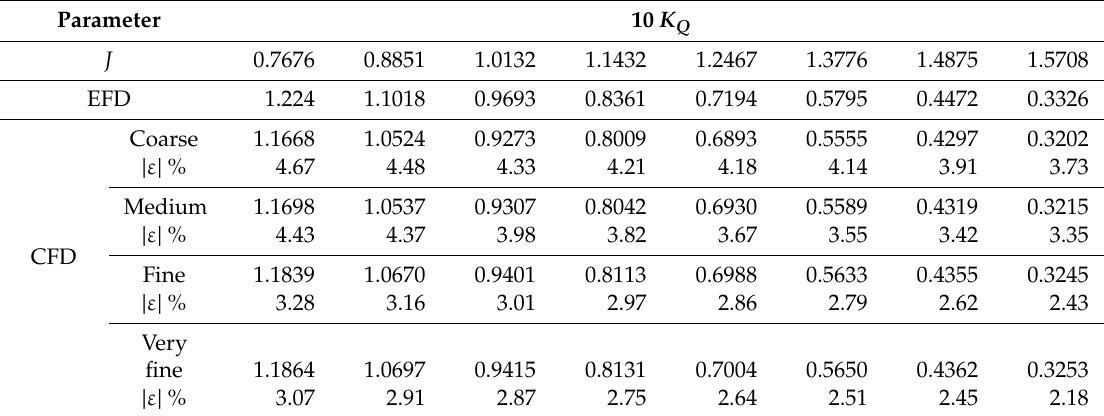
Table 8. Grid convergence test for the torque coe ffi cient. Propeller working in cavitation tunnel.